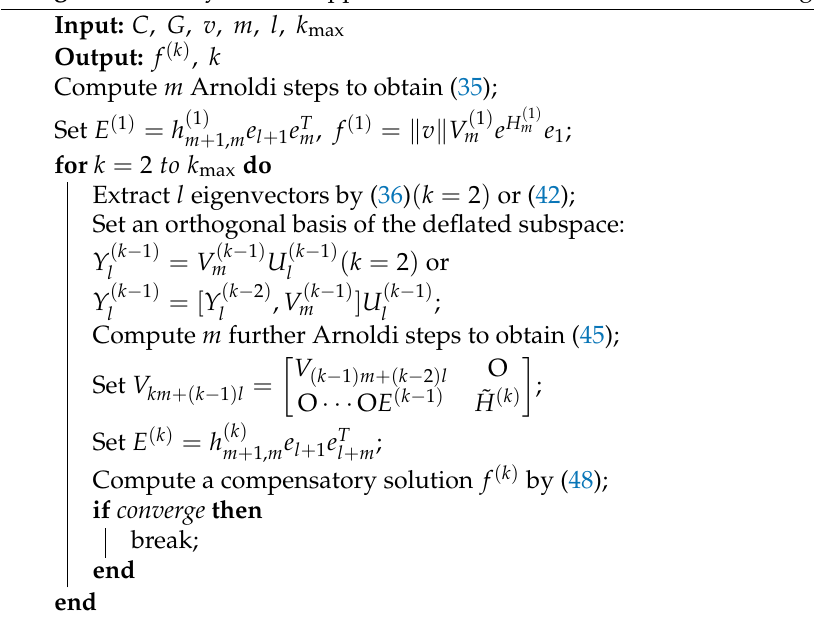
Algorithm 3: Krylov-like Approximation of EI with Deflated